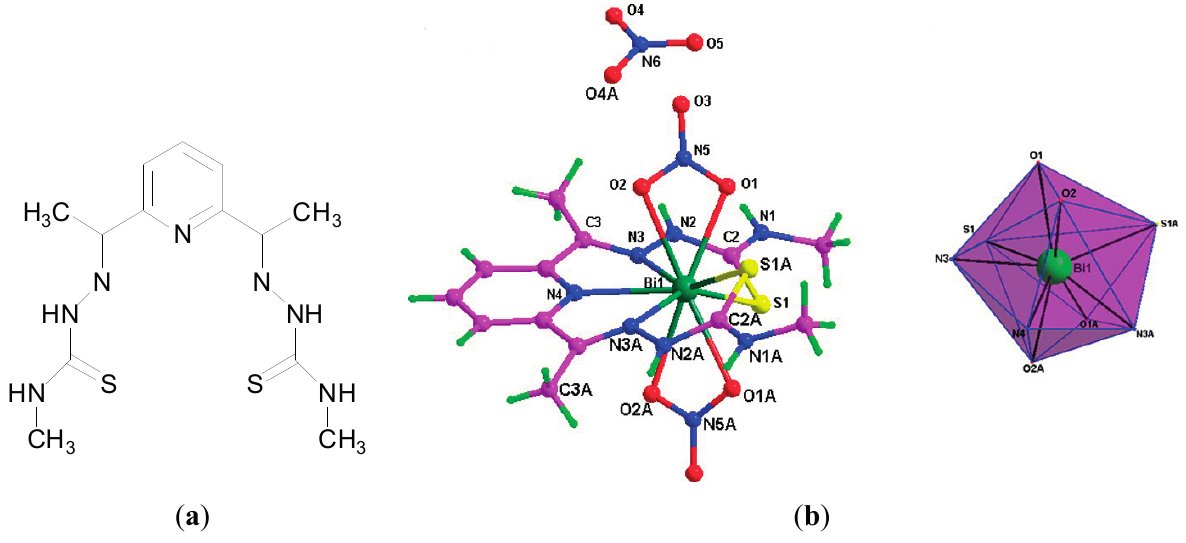
Figure 17. ( a ) Structure of 2,6-diacetylpyridine bis( 4 N -methylthiosemicarbazone) (H 2 L); ( b ) Molecular structure of [Bi(H 2 L)(NO 3 ) 2 ]NO 3 atomic numbering and polyhedral showing distorted geometry around the Bi atom. Reprinted with permission from [19]. Copyright (2012) American Chemical Society.